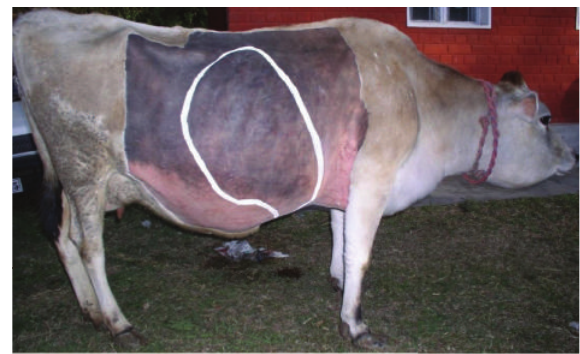
Figure 8: Ultrasonographic topography of the enlarged liver based on its mean dorsoventral extent in 5 cows a ff ected by pericarditis.